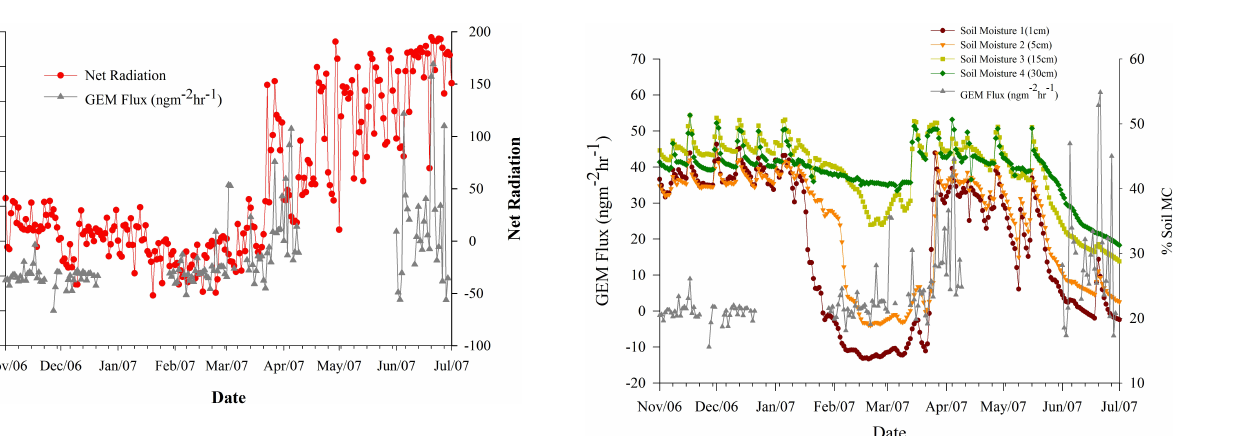
Fig. 8. Daily averages of GEM flux (ngm − 2 hr − 1 ), net radiation (Wattsm − 2 ) and relative humidity (% RH) with time (1 November 2006 to 29 June 2007) measured at Elora Research Station, ON.